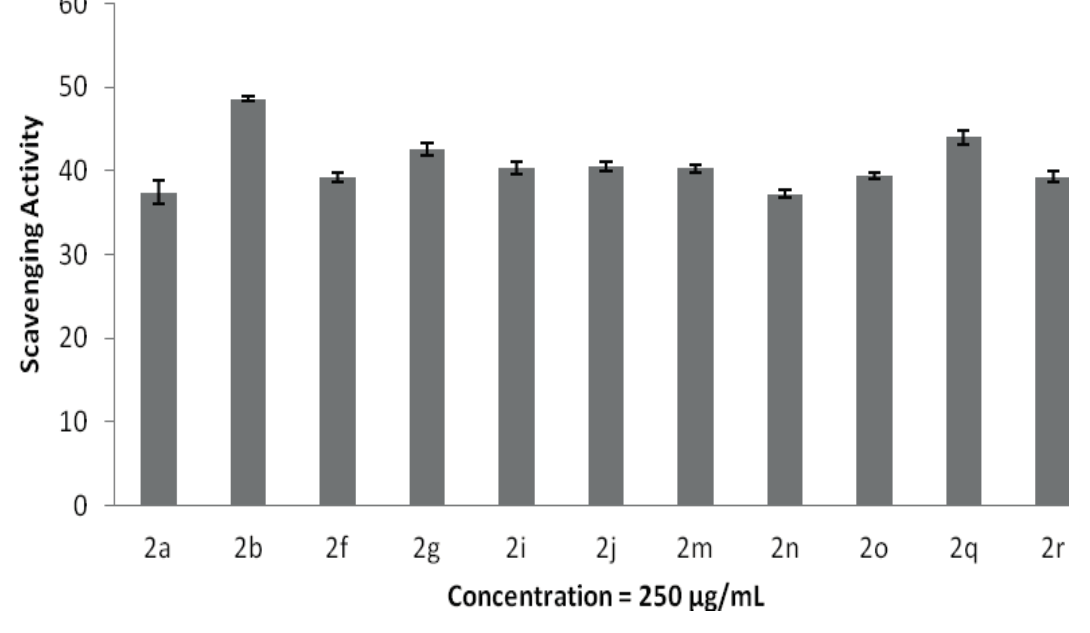
Figure 8. Hydrogen peroxide radical scavenging. The data represent the percentage of hydrogen peroxide radical inhibition (mean ± SD), and experiments were performed in